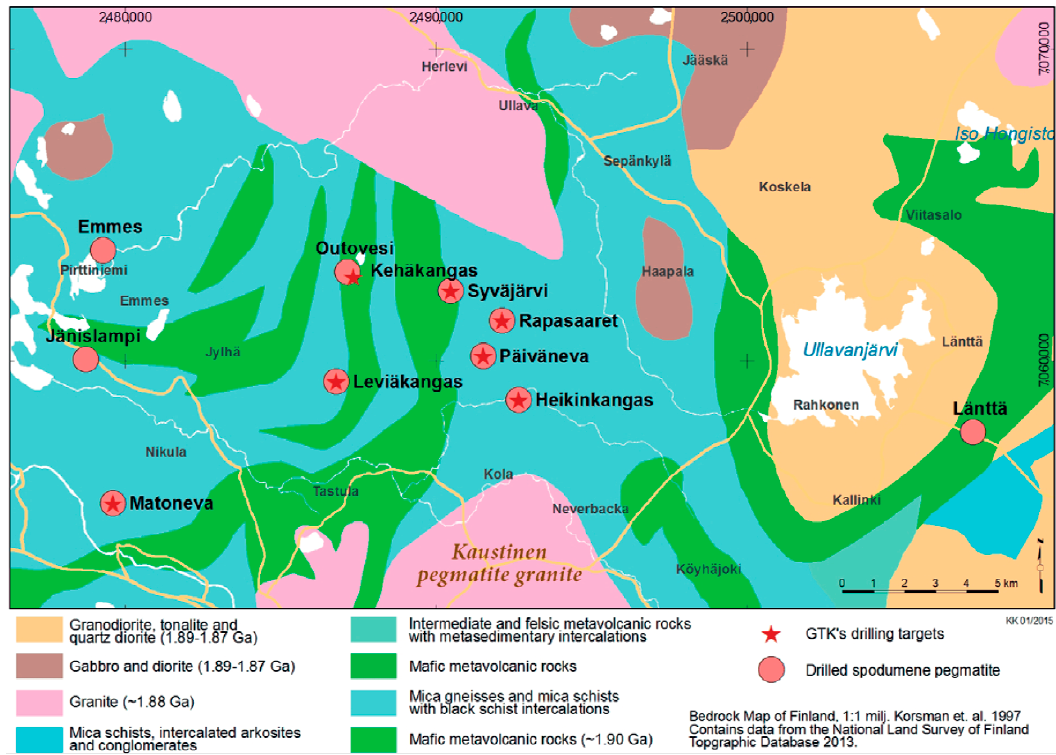
Figure 9. The Kaustinen Li pegmatite province, western Finland, showing the locations of the drilled spodumene pegmatites between 2004 and 2012. From Ahtola et al. (2015) [56].